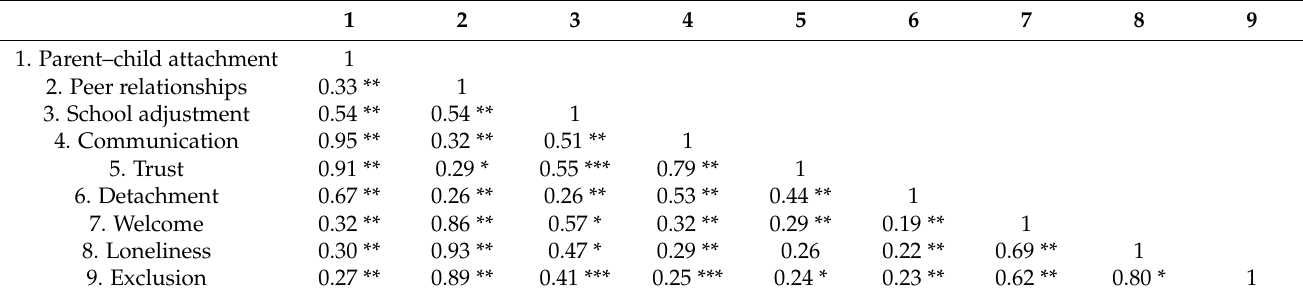
Table 2. Analysis of correlations among variables in transnational parenting of left-behind children (n = 405).